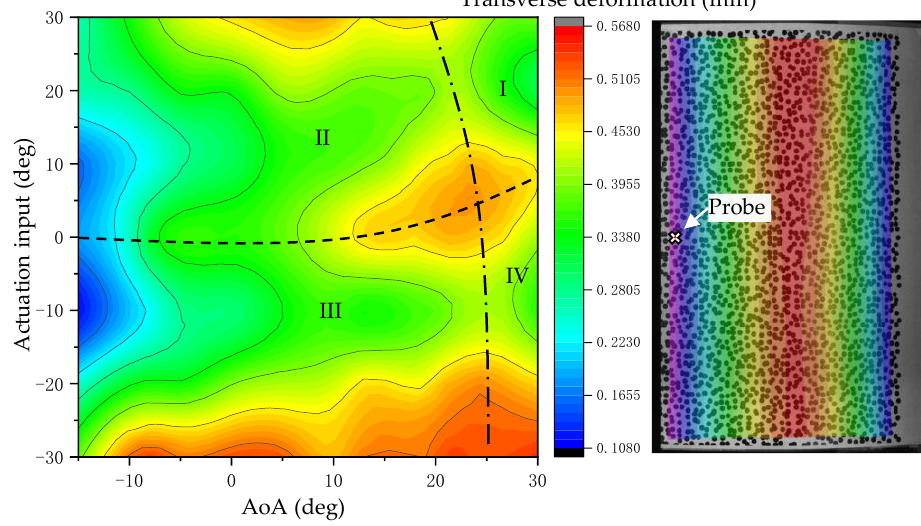
Figure 27. Static aeroelastic deformation of probe point on mTE4 (Airspeed 10 m/s). The black dashed and dotted lines divide the region into four quadrants, as